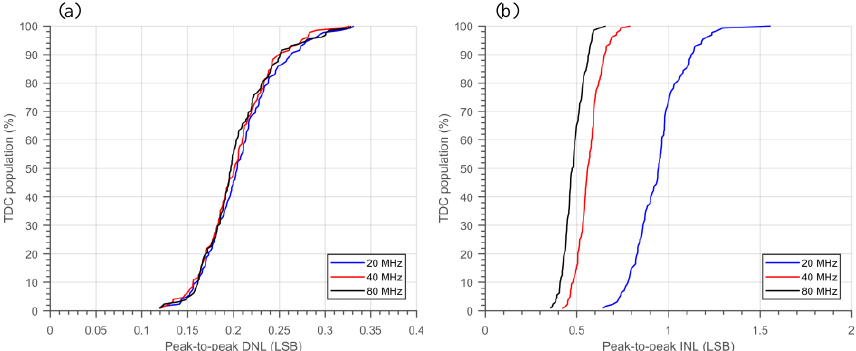
Figure 12. TDC ( a ) DNL and ( b ) INL measurement with different STOP frequency.